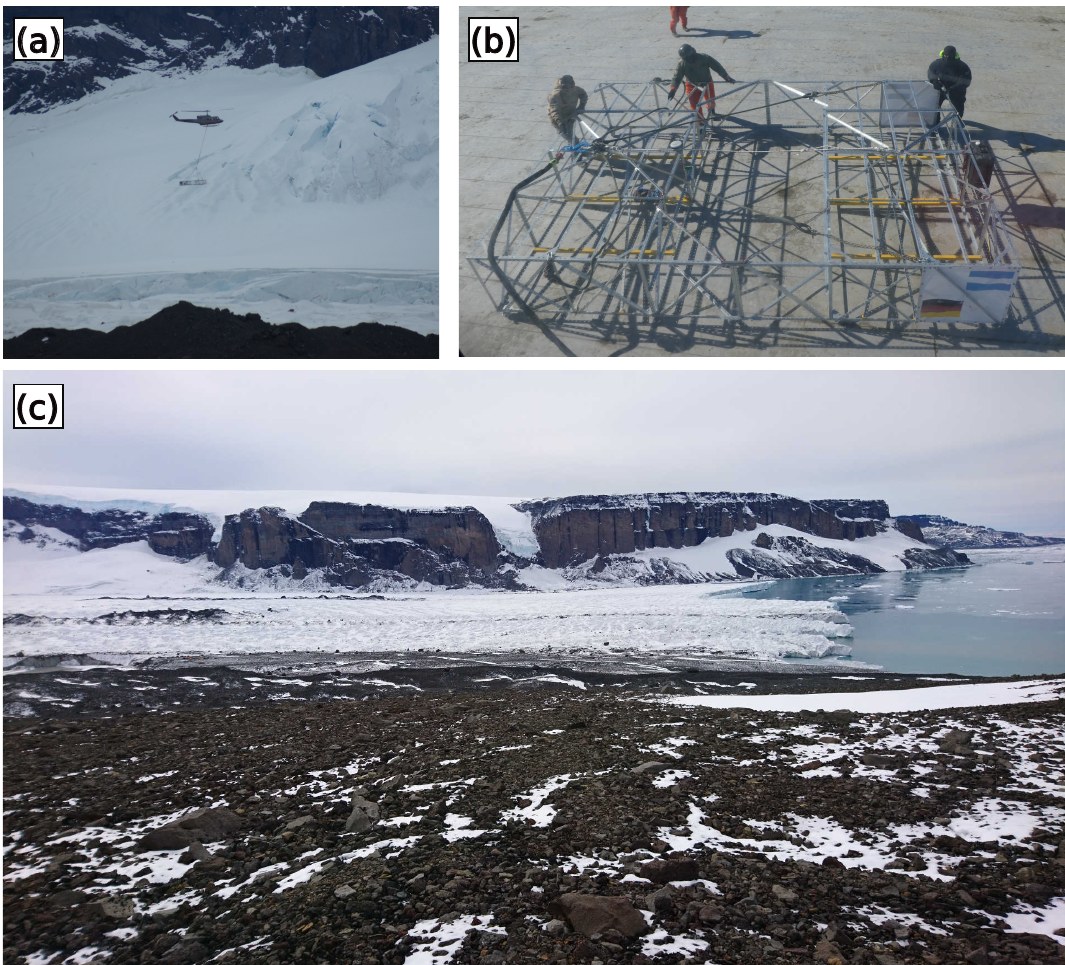
Figure A1. ( a ) The GPR antenna flown as a sling load by a Bell 212 helicopter. ( b ) Detailed view of the GPR antenna system. ( c ) The frontal part of Gourdon Glacier with the northern cliff boundary, photographed from the southern